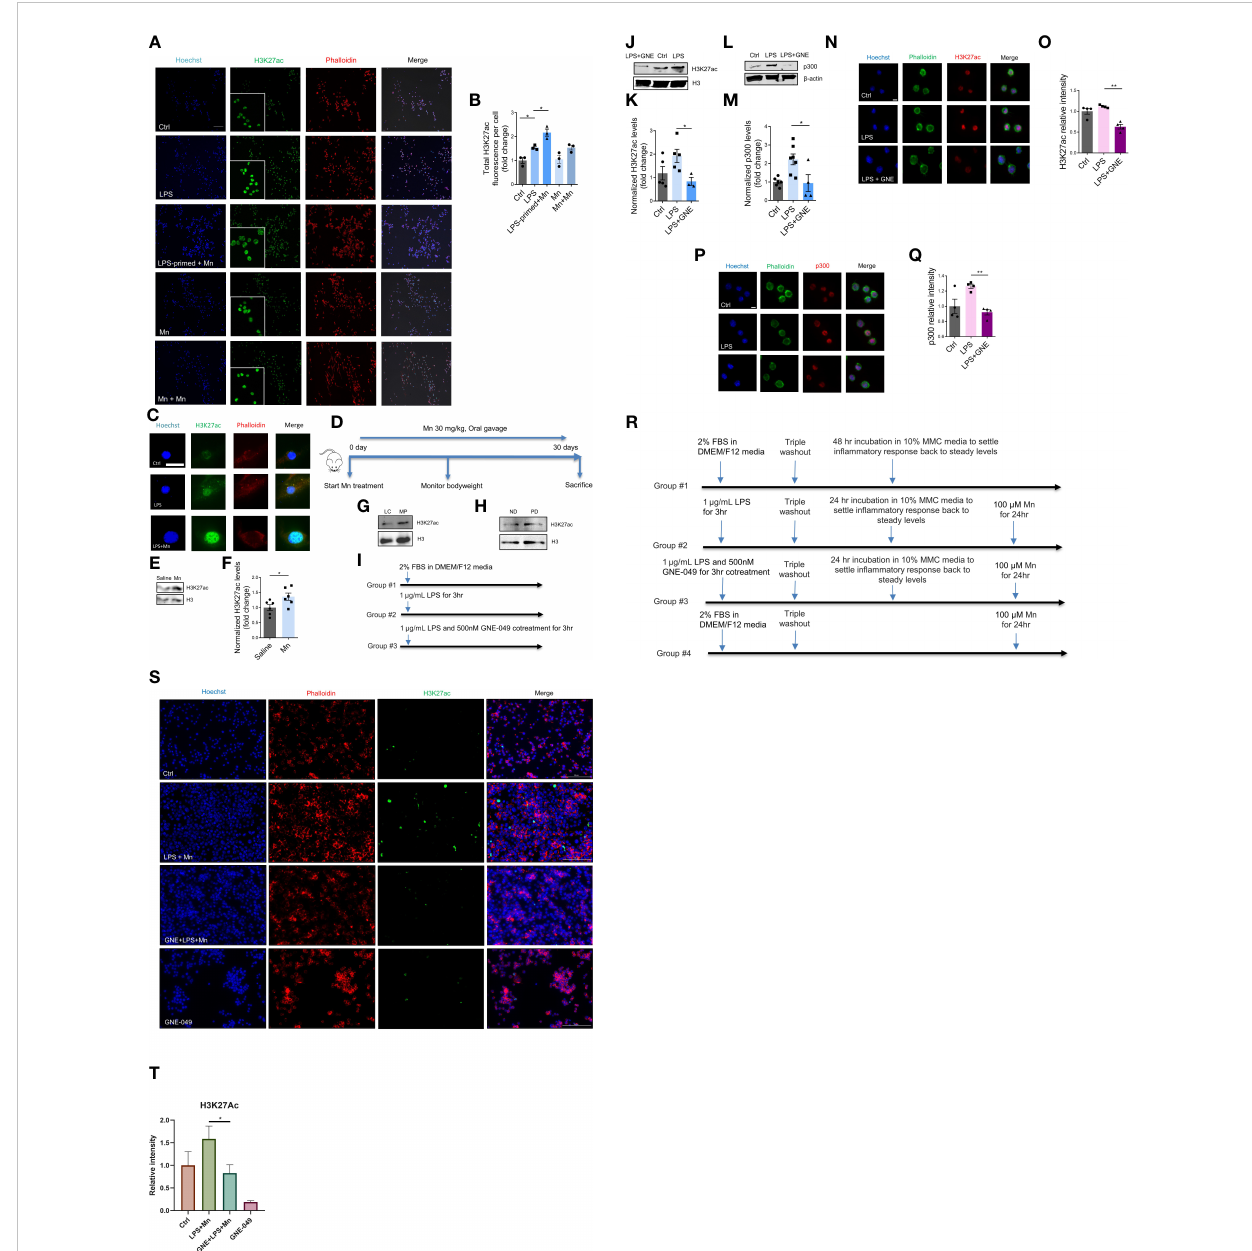
FIGURE 2 H3K27ac deposition in microglial cells and mice in response to LPS priming and subsequent Mn exposure. (A) Representative ICC images of H3K27ac in MMCs primed with LPS and treated as indicated, with phalloidin-stained cytoplasm in red, Hoechst-stained nuclei in blue, and H3K27ac in green (n=3). Scale bar, 100 µm. (B) Immuno fl uorescence microscopy analyses of total H3K27ac intensity per cell. Calculation was automatically performed by Keyence microscope software. (C) Immuno fl uorescence microscopy analysis of H3K27ac in Mn-exposed, LPS-primed PMG cells.